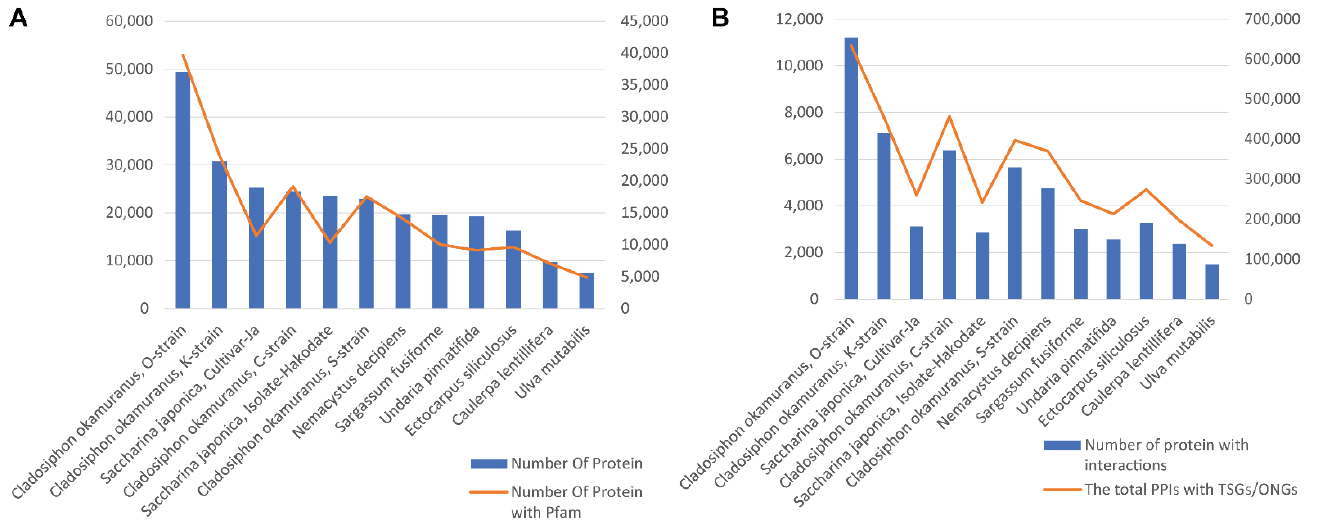
Figure 2. A web browsing interface for the interactome between human cancer genes and twelve edible seaweed genomes. ( A ) The homepage includes the data search interface, and the data down- load links. ( B ) The search result will guide the user to each cancer-related gene page. ( C ) On each gene page, we provide basic annotation information, such as gene ontology and KEGG pathway of the cancer genes.